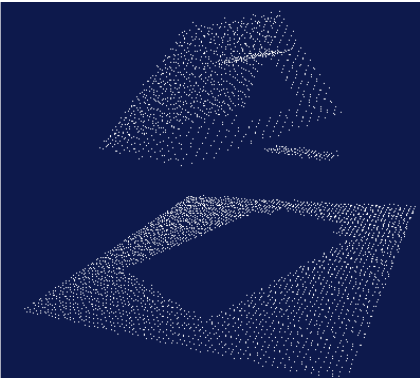
Fig. 4. Simulated input data.